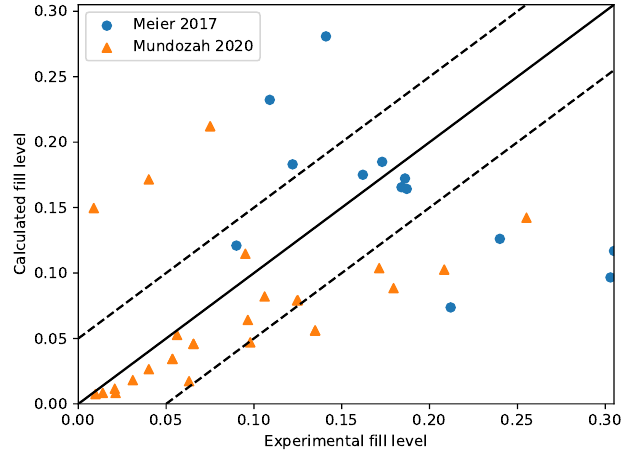
Figure 3. A parity plot comparing the predicted values of fill level with experimental values. The dot- ted lines represent confidence intervals of 0.05. The correlation has good prediction capability with 80% points lying between the 2 confidence intervals [28,36].